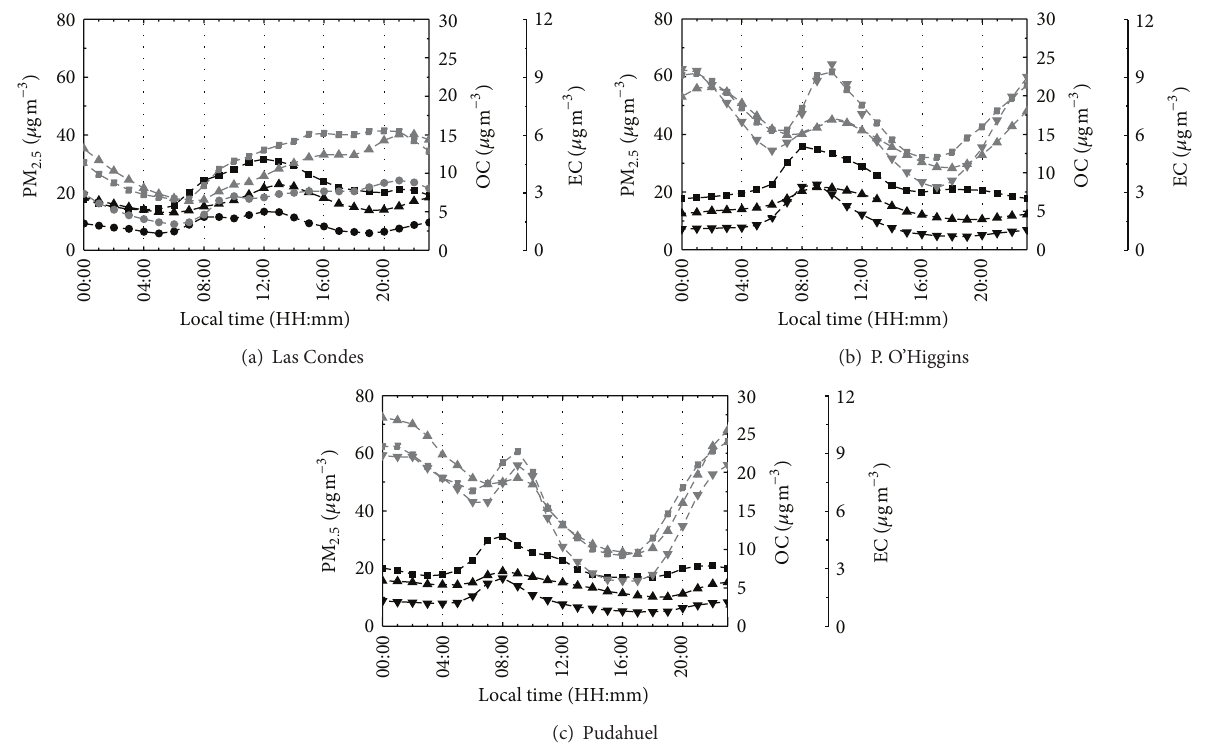
Figure 3: Daily mass concentration (in 𝜇 g/m 3 ) in the cool (gray) and warm seasons (black) of PM 2.5 (black square, grey square), organic carbon (OC; grey triangle), and elemental carbon (EC; inverted triangle) in PM 2.5 at the (a) Las Condes (labeled C), (b) Parque O’Higgins (labeled O), and (c) Pudahuel (labeled P) stations in the cool (gray line) and warm (black line,) seasons. Label of the stations in Figure 1: Las Condes: C Label, P. O’Higgins: O Label, and Pudahuel: P Label. Data source: Chilean Ministry of Health, Metropolitan area